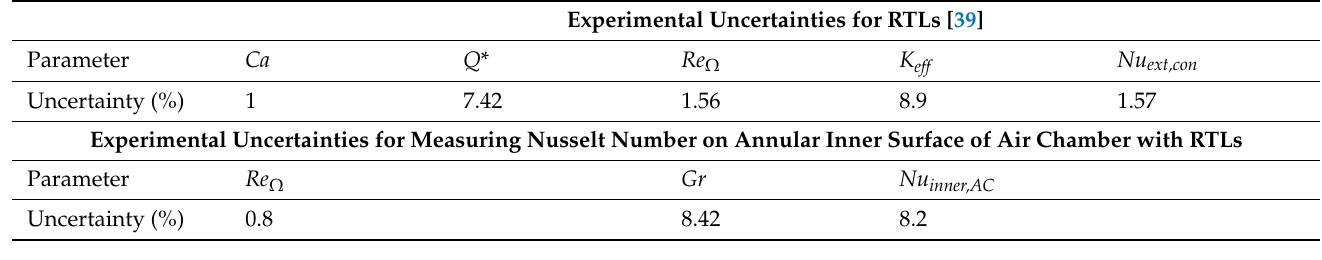
Figure 5. An illustrative set of T w , σε ( T 4 w − T 4 ∞ ), h free-convection ( T w − T ∞ ), k w t ∇ 2 T w , and ρ m C m ∂ T w ∂ t leading to generation of h map over the scanned inner annular surface of the air chamber, within which five 180 ◦ condenser bends rotate at 2000 rev/min. Table 1. Experimental uncertainties of the